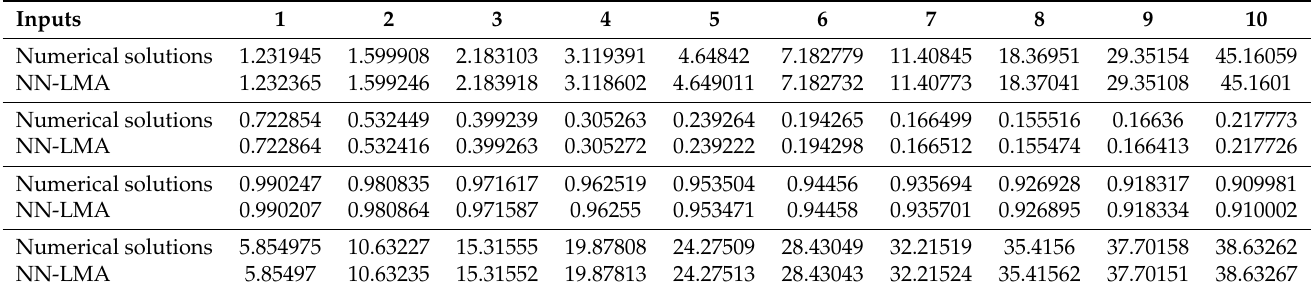
Table 7. Comparative analysis of numerical solutions by NDSolve tool in Mathematica with the solutions obtained from NN-LMA for case 2.